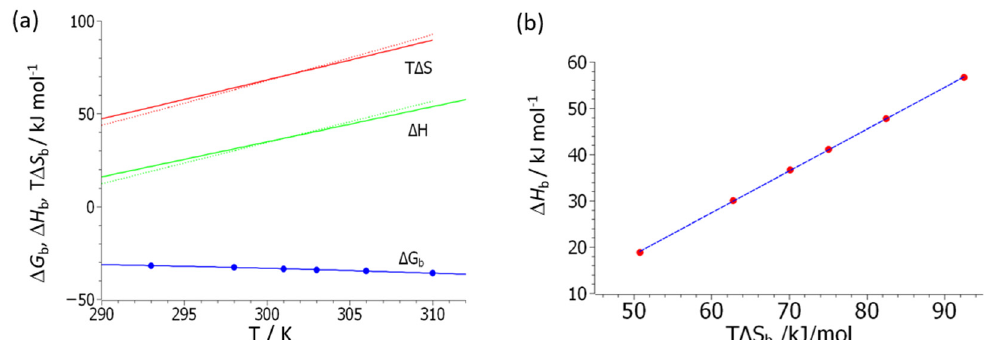
Figure 5. Enthalpy–entropy compensation for the data obtained from polymer 3 (primary amine). ( a ) The blue circles denote the measured free energy of binding, whereas the blue solid line gives the respective fit by Equation (14). The solid green and red lines give the enthalpy Equation (15) and the entropy multiplied by T as obtained from Equation (16), respectively. The respective dashed lines denote the enthalpy Equation (4) and the entropy Equation (5) deriving from the fit of Equation (7) to the experimental data. ( b ) The enthalpy, Δ H b (cf. Equation (4)), obtained from the fit of the experimental data according to Equation (7) is plotted against T Δ S b (Equation (5)). The slope of the dashed line is 0.9, indicating an incomplete compensation of enthalpy by entropy. See text for further explanation.